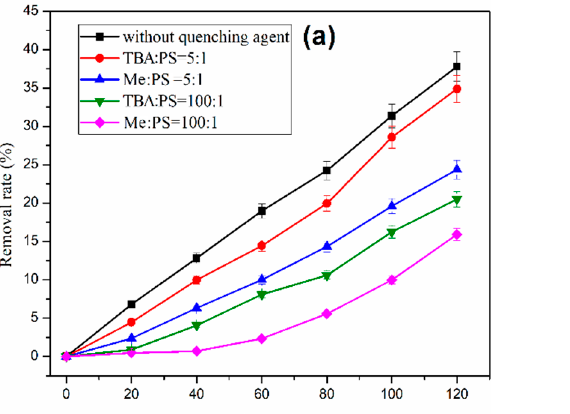
Figure 9. Effects of initial pH on ciprofloxacin removal.